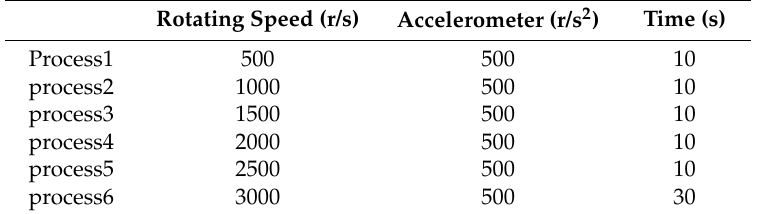
Table 6. Parameters used for the polyimide film spin coating process.